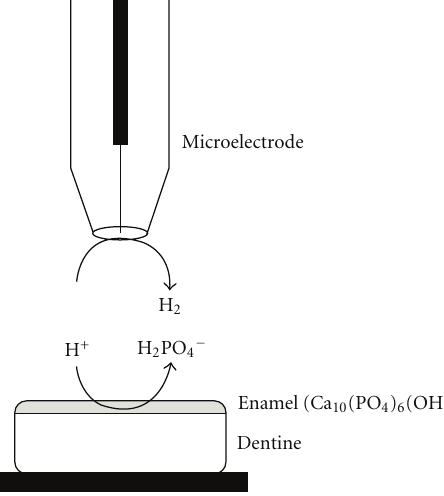
Figure 3: Schematic representation of the SECM